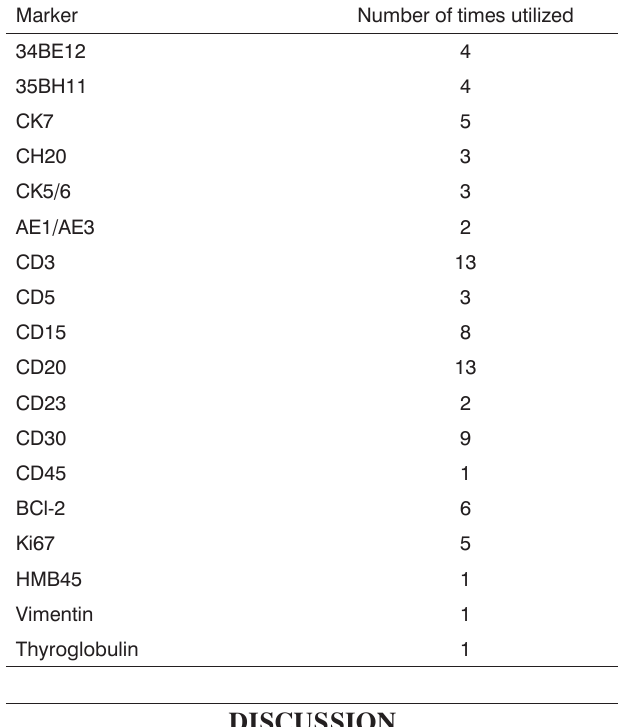
Table 1. Distribution of histological cell lines (n = 32).